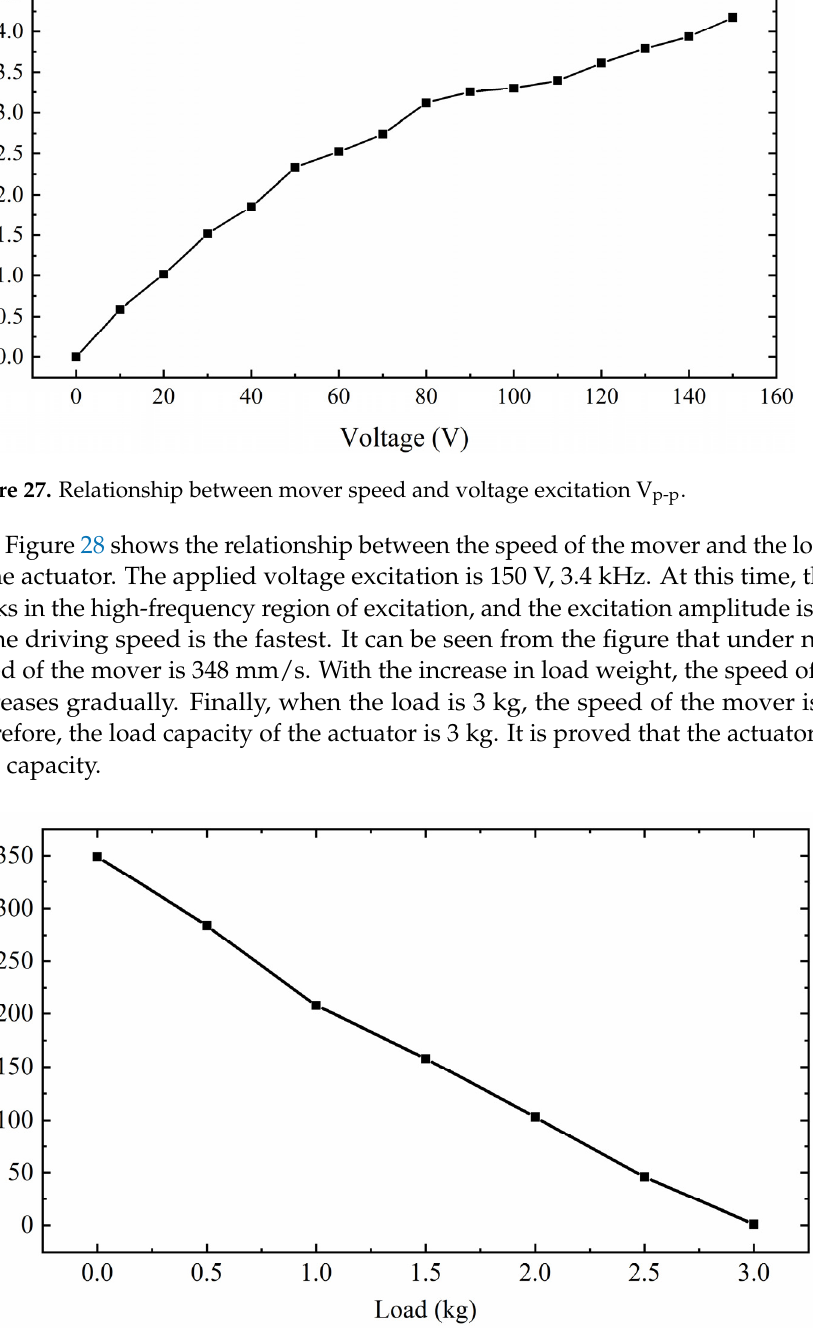
Figure 28. Relationship between mover speed and load capacity.